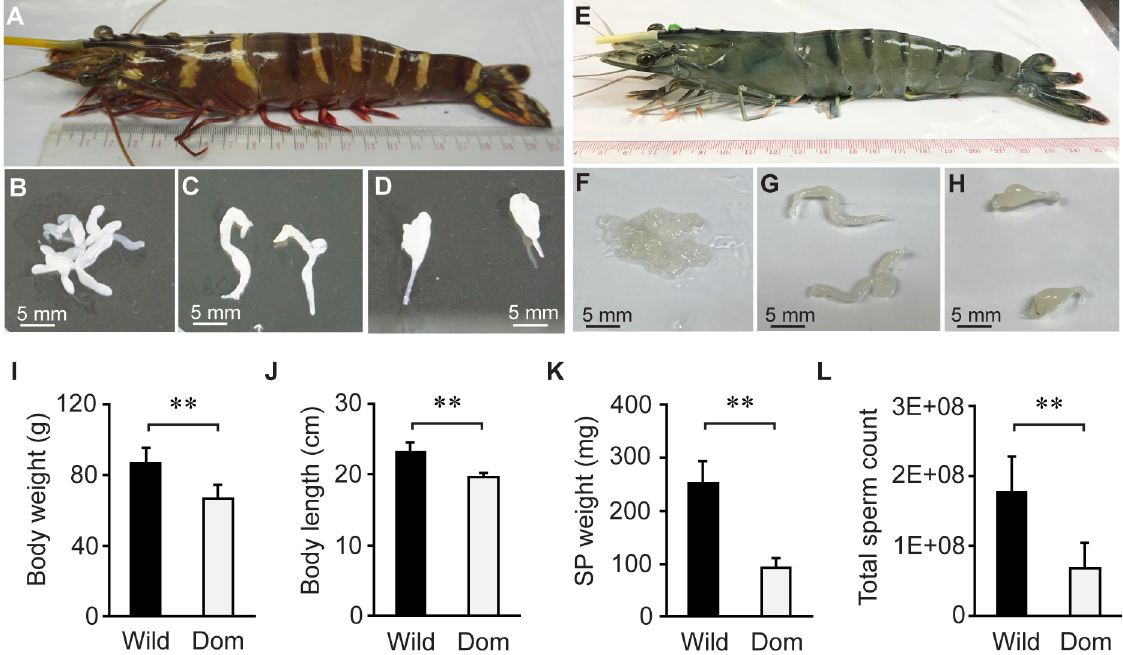
Fig 1. Wild-caught shrimp had higher body weight, body length, spermatophore weight, and total sperm count than domesticated shrimp. (A) Wild-caught shrimp ( N = 10) were dissected to obtain (B) testes, (C) vas deferens, and (D) spermatophores. Dissection of (E) eleven-month-old, domesticated shrimp ( N = 10) were also performed to collect (F) testes, (G) vas deferens, and (H) spermatophores for the analysis. Comparative analysis of (I) shrimp body weight, (J) body length, (K) spermatophore weight, and (L) total sperm count was performed between wild-caught (Wild; black bars) and domesticated shrimp (Dom; white bars). Error bars represent standard deviations. Asterisks indicate a significant difference between samples using the t -test ( �� for P < 0.01).